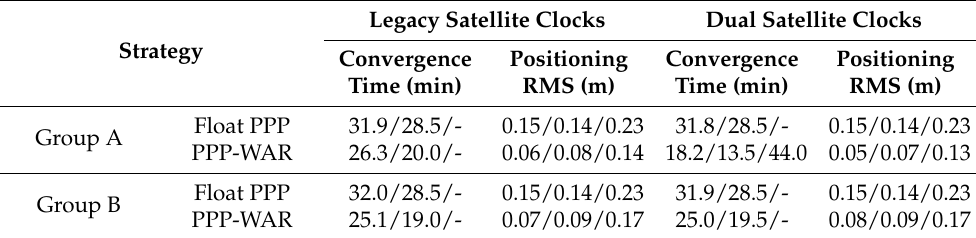
Table 4. PPP-WAR convergence times and positioning precisions for one month of solutions. Mean, 50th, and 90th percentiles of the convergence time are given and delimited by two slashes. “-“ denotes those solutions that did not converge within 1 h. Note that only the first ten minutes of each solution was used to calculate the positioning RMS.